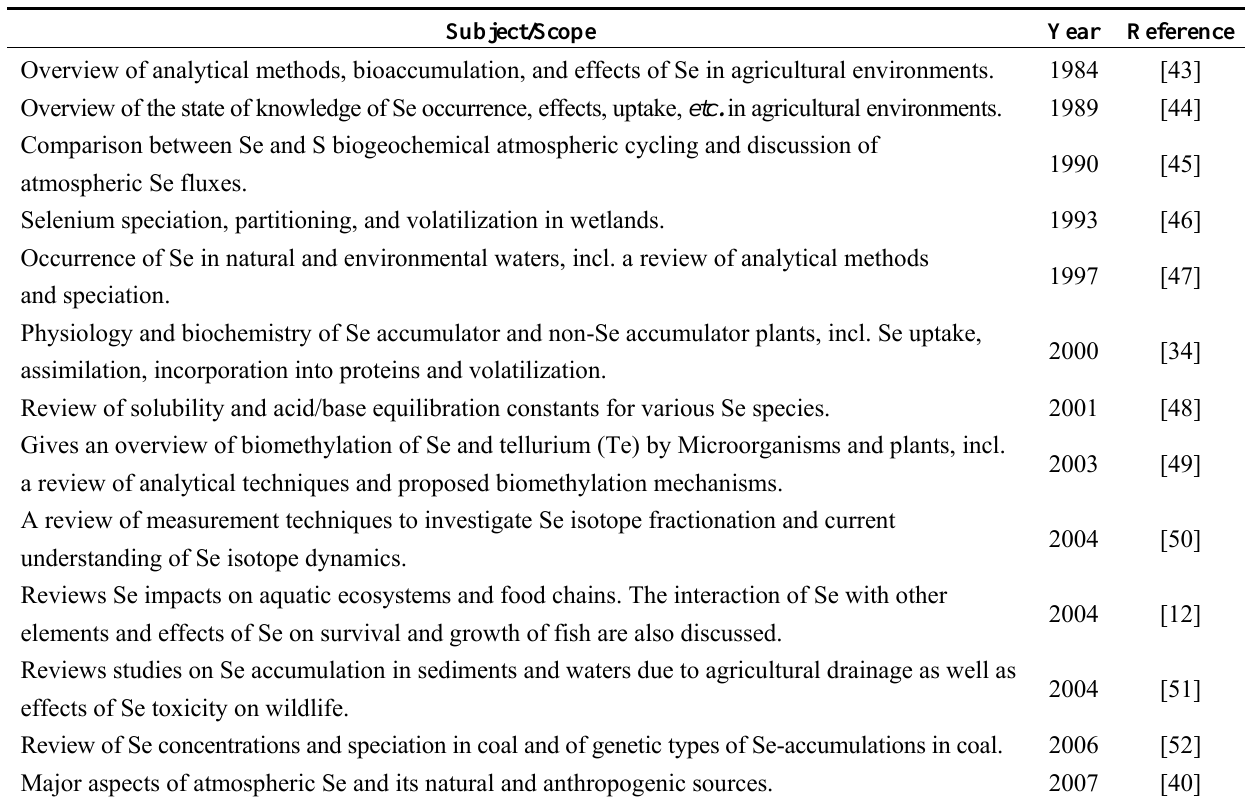
Table 1. Main reviews on various aspects of Se in the environment. Reviews on the role of Se in human and animal health, food and advances in analytical methods are not